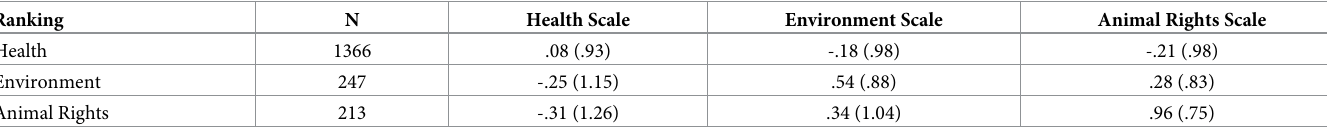
Table 4. Standardized means for three VEMI scales among people who ranked health, environment, and animal rights as most important factor in considering a vegetarian